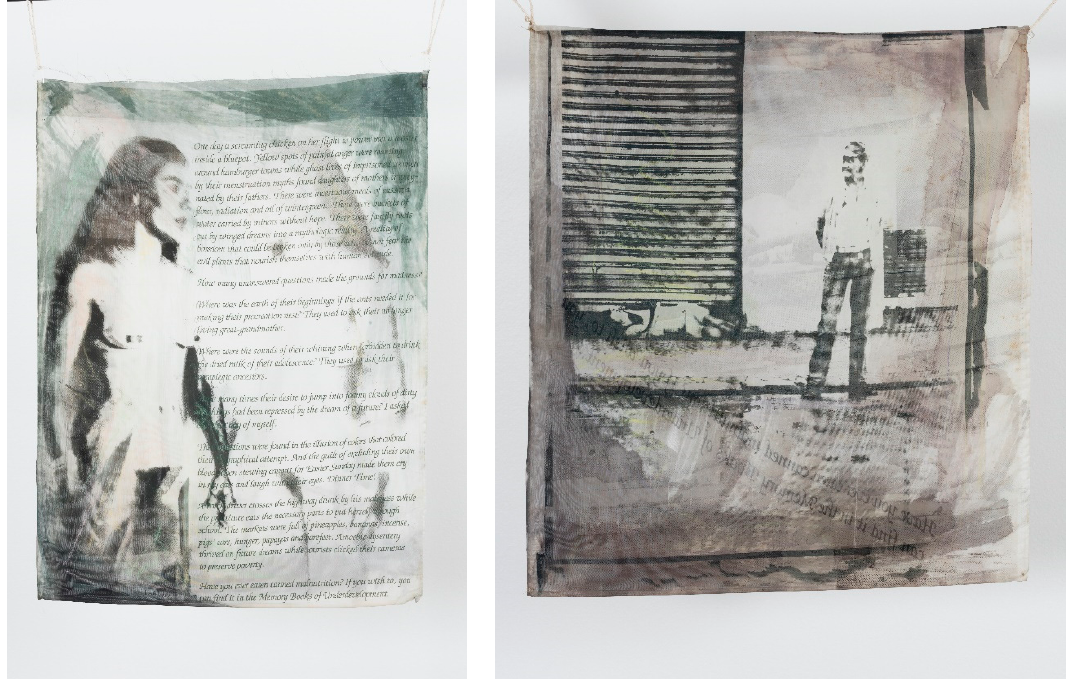
Figure 5. Josely Carvalho, From the Memory Books of Underdevelopment , 1983, Artist book, 8 pockets, silkscreen, dyes on silk and acrylic, different sizes. Courtesy of the artist. Image credit: Pat Kilgore, used by permission.